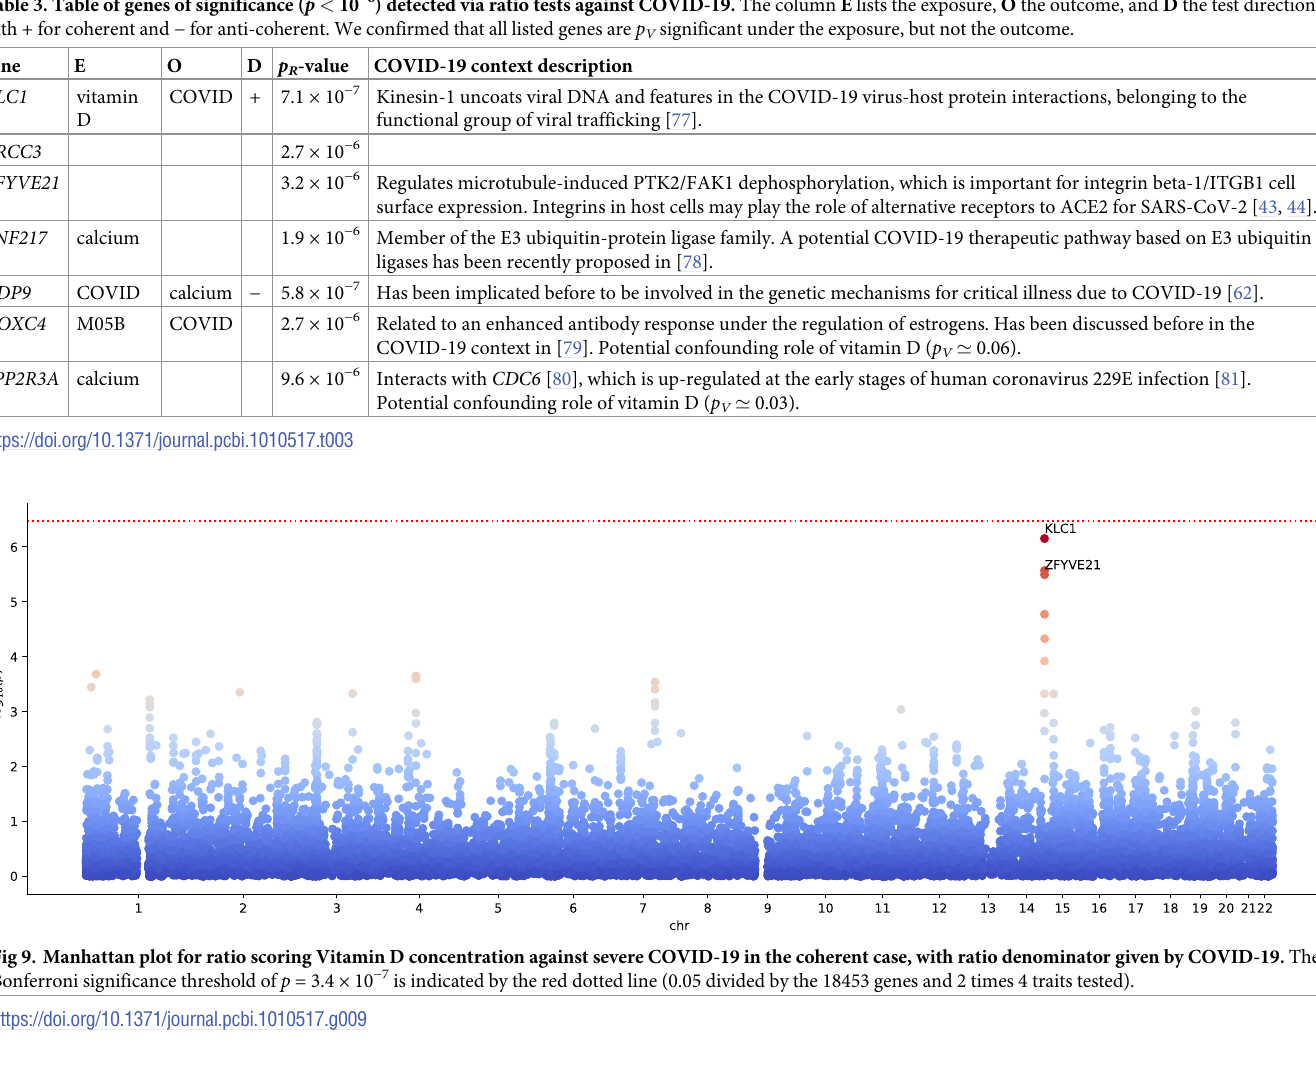
not LZTFL1 . Also, while CCR9 and CXCR6 cross the p < 10 − 6 threshold under the coherence test, not so under the simple single-element product-normal test. This confirms that the coher- ence test can improve the signal strength and may lead to fewer false negatives. Fig 10B shows severe COVID-19 against RA. While, again, all Bonferroni significant genes are also